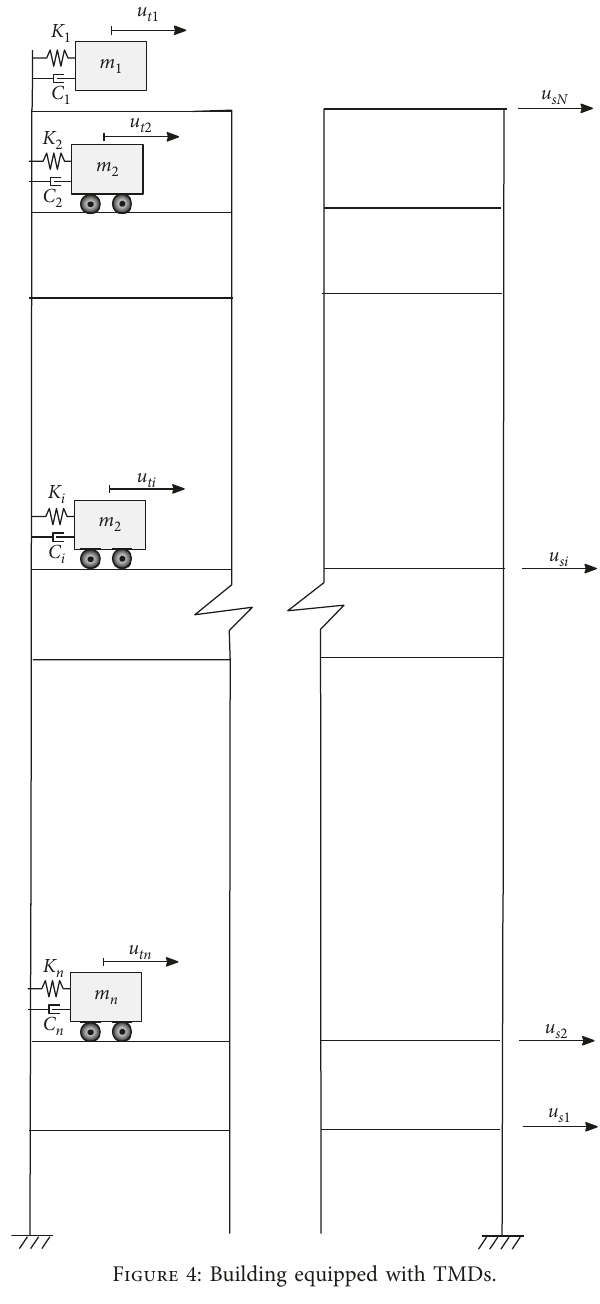
Figure 4: Building equipped with TMDs.